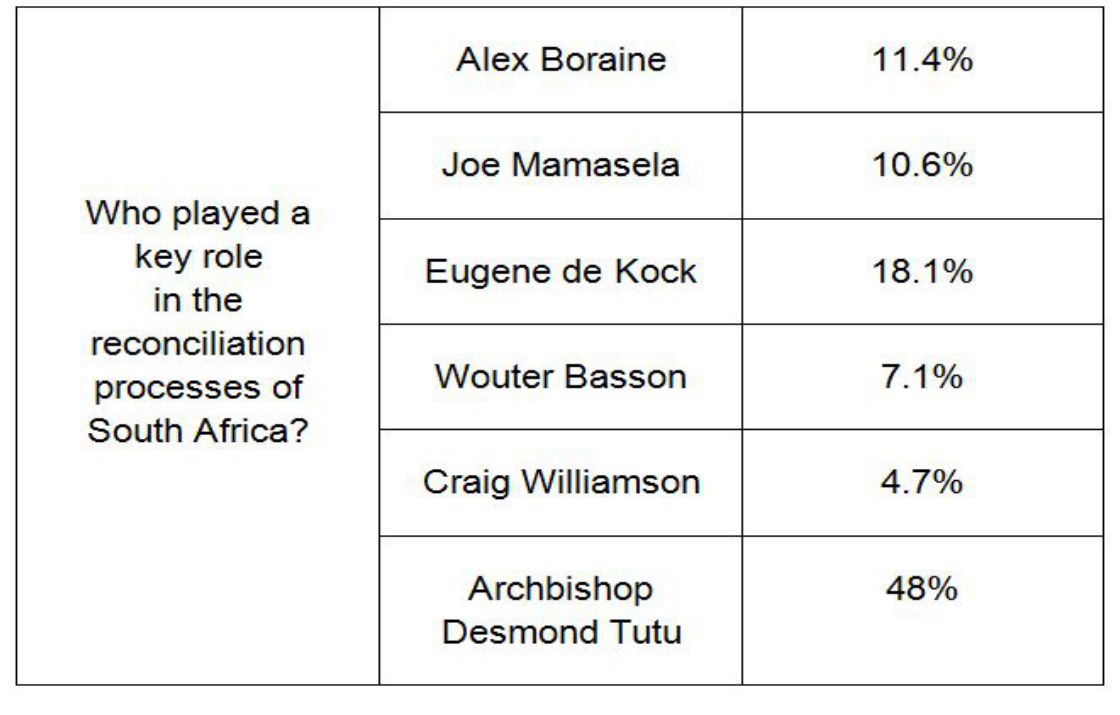
Students’ responses when asked about the persons who played